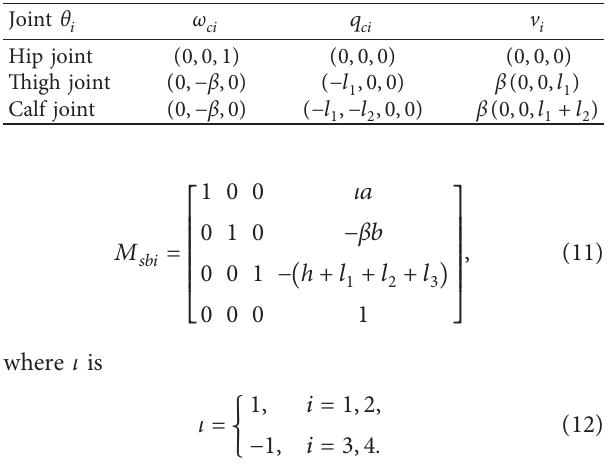
Table 2: The spiral axis of the leg joints in the reference coordinate